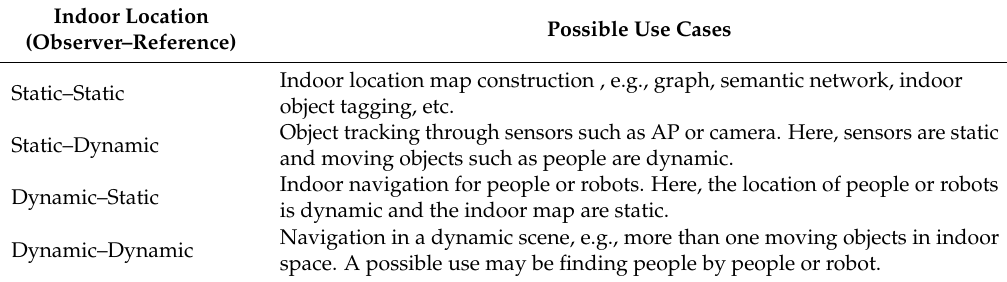
Figure 3. 4th teaching building on the Xipu campus of Southwest Jiaotong University.